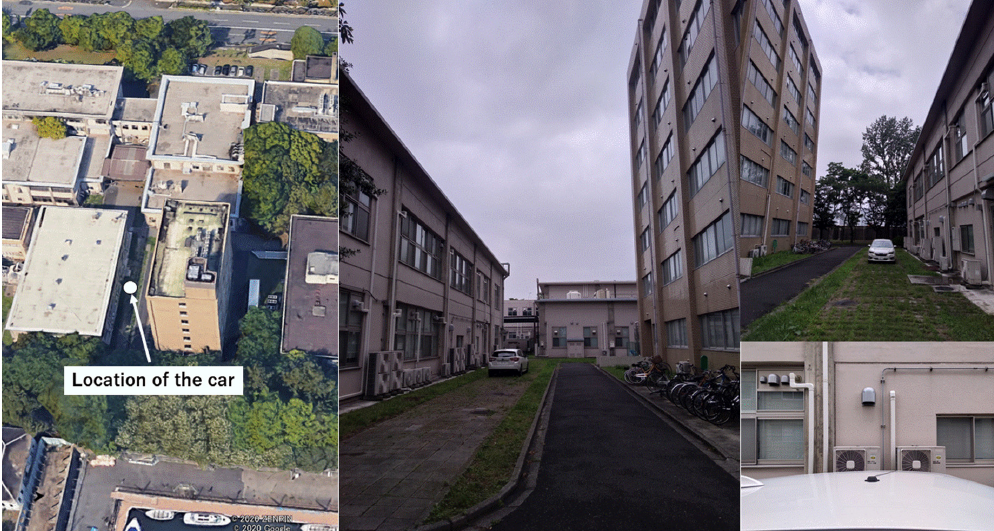
Figure 19 . Location of car and detailed images around antenna. Figure 19. Location of car and detailed images around